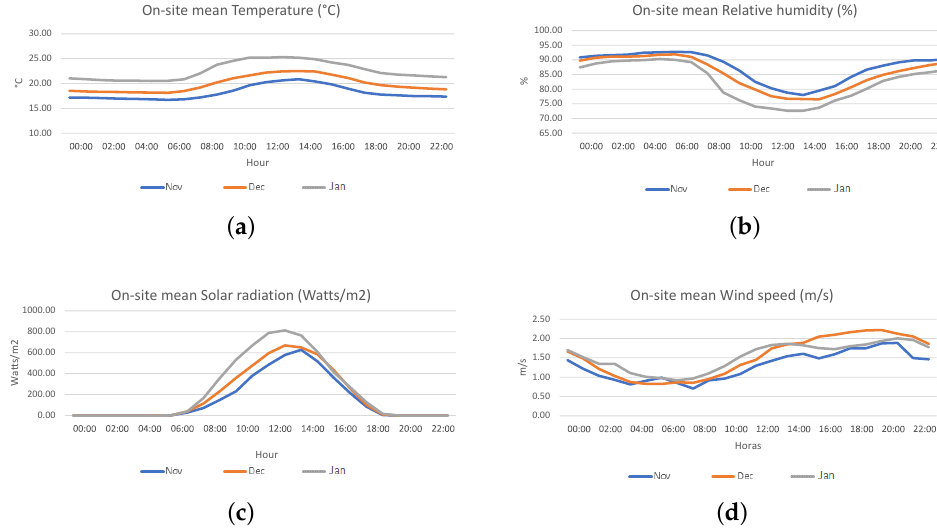
Figure 2. Plots of hourly mean temperature ( a ), relative humidity ( b ), solar radiation ( c ) and wind speed ( d ) for the three months involved in the study (November 2021 to January 2022). The hourly mean temperature and solar radiation increase with the arrival of summer (December–March), while the humidity